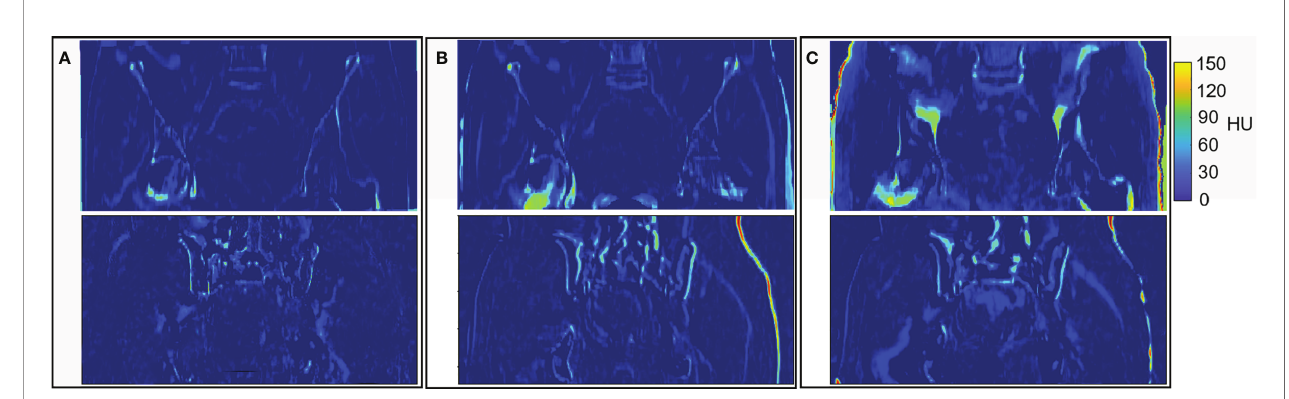
FIGURE 5 | Results of HU values difference between CT gt and pseudo CT obtained by different deep learning methods. (A) HU values difference between CT gt and CT CycleGAN . (B) HU values difference between CT gt and CT unet-GAN . (C) HU values difference between CT gt and CT FCN-GAN